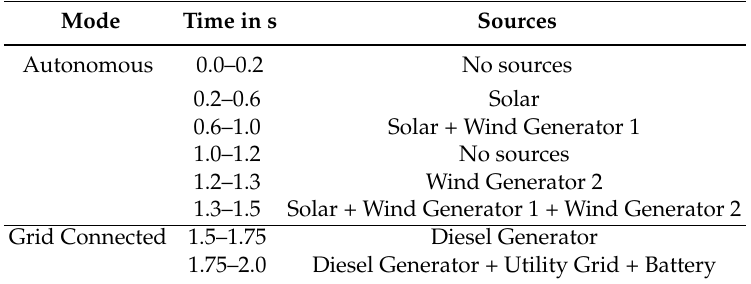
Table 6. Modes of operation with power from Various sources in AC bus